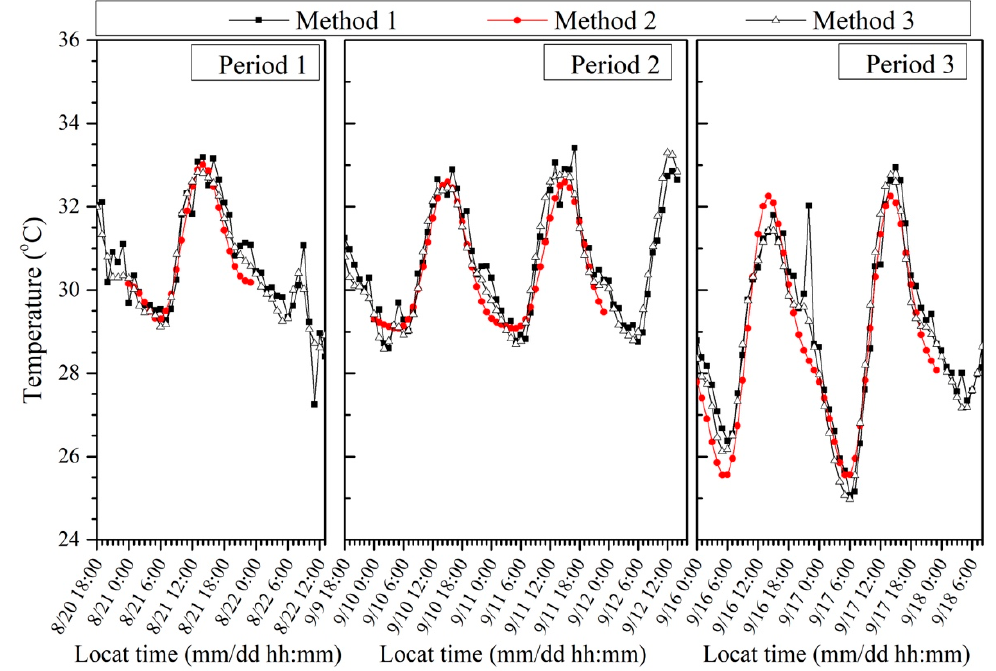
Figure 10. Hourly average air temperature in the street calculated from three different averaging methods in different periods.